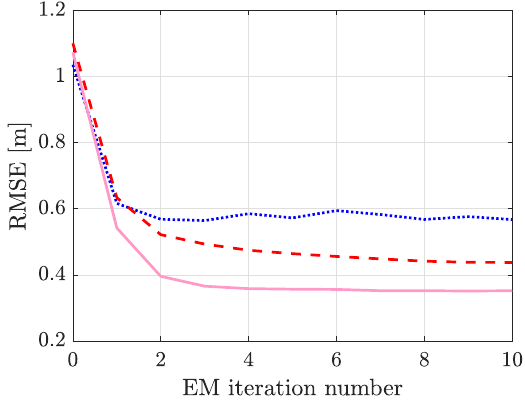
Figure 6. The RMSE, averaged over the 18 different experiments, as a function of EM iteration number. The DFLT methods are: EKF ( ), RTI ( ) and PF (